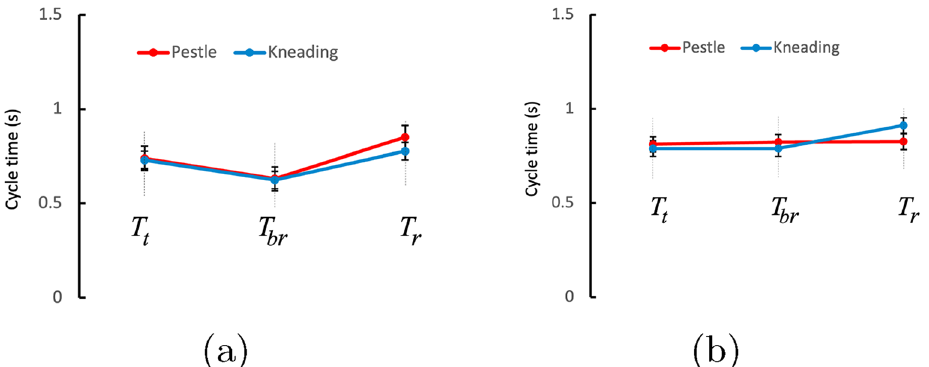
Fig. 6 T t - T br - T r Evolution for a implicit pair and b explicit pair